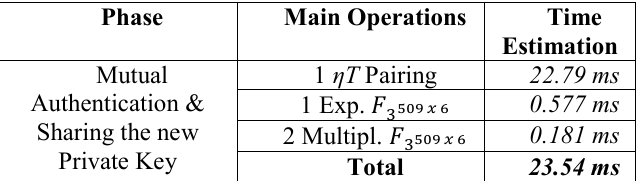
Table III. Estimation of RFID-Tate at 416 MHz